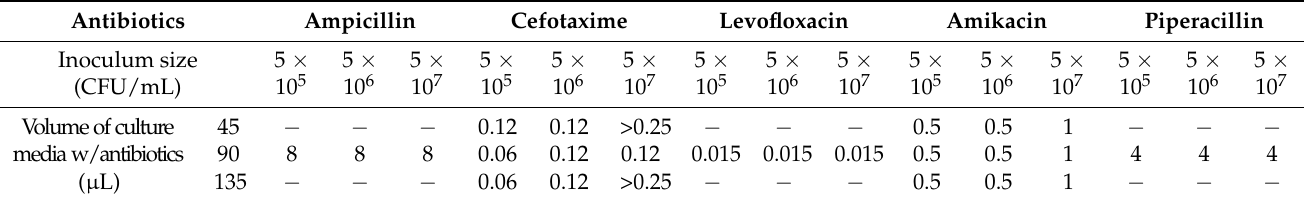
Table 3. MIC values of E. coli according to different bacterial inoculum sizes and volumes of culture media with antibiotics. The unit of MIC is µ g/mL.